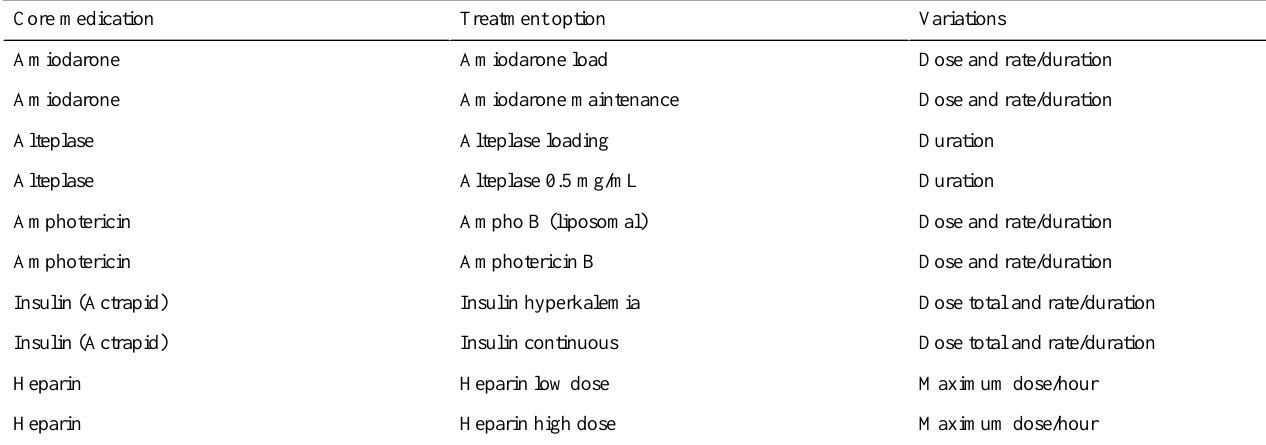
Table 2. Examples of individual entities for